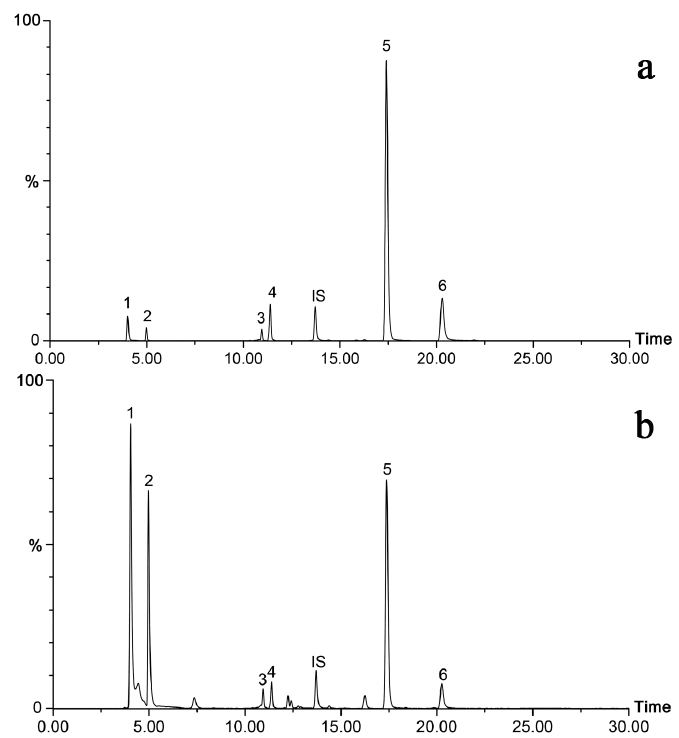
Figure 2. UPLC-MS/MS multiple reaction mode (MRM) chromatograms of ( a ) mixed standards